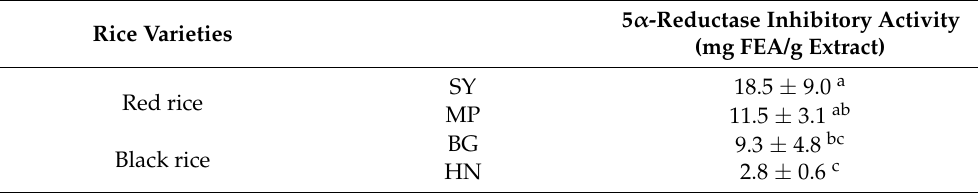
Table 1. 5 α -reductase inhibitory activity of red (SY and MP) and black (BG and HN) rice extracts. Rice Varieties